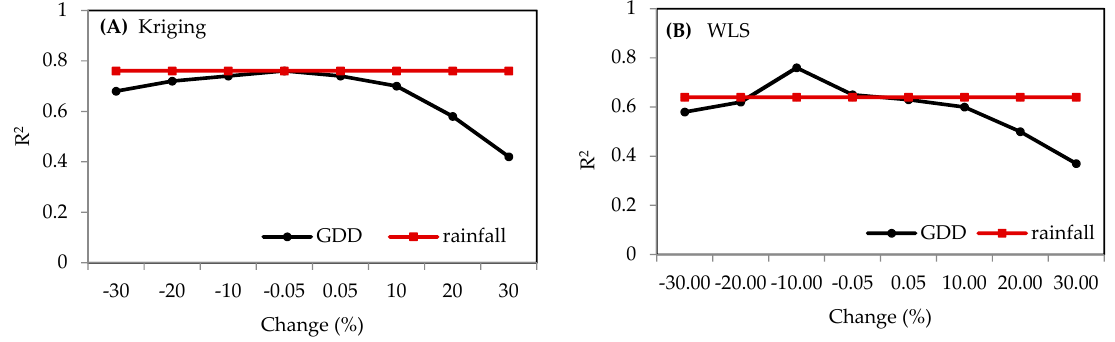
Figure 3. The result of sensitivity analyses of rainfall (Kriging ( A ) vs. WLS ( B )) and GDD.